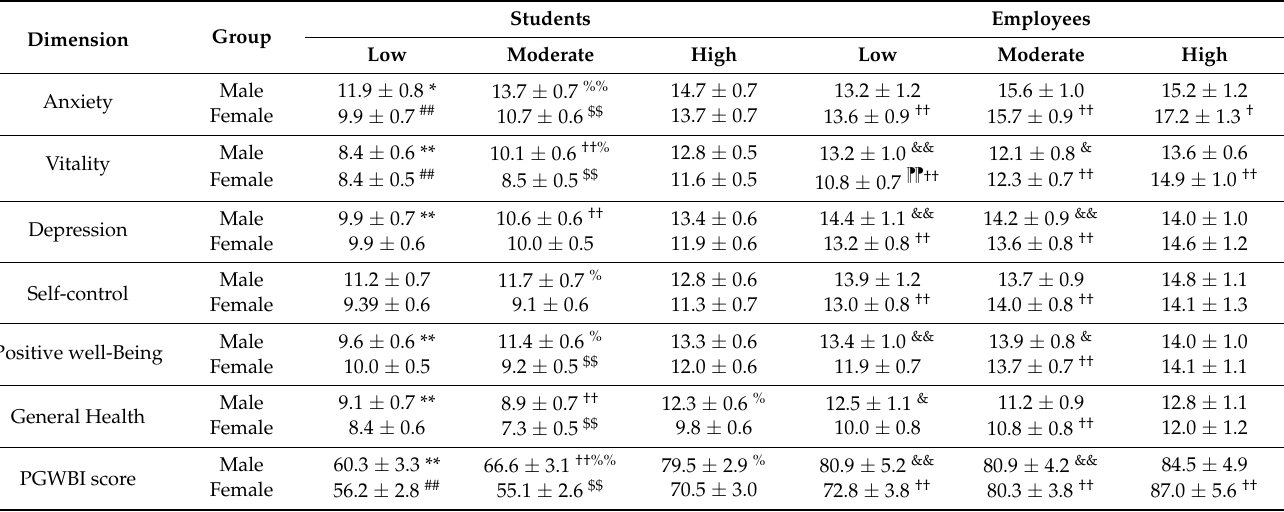
Table 3. Mean of PGWBI score and dimensions for male and female according to PA level during Lockdown.